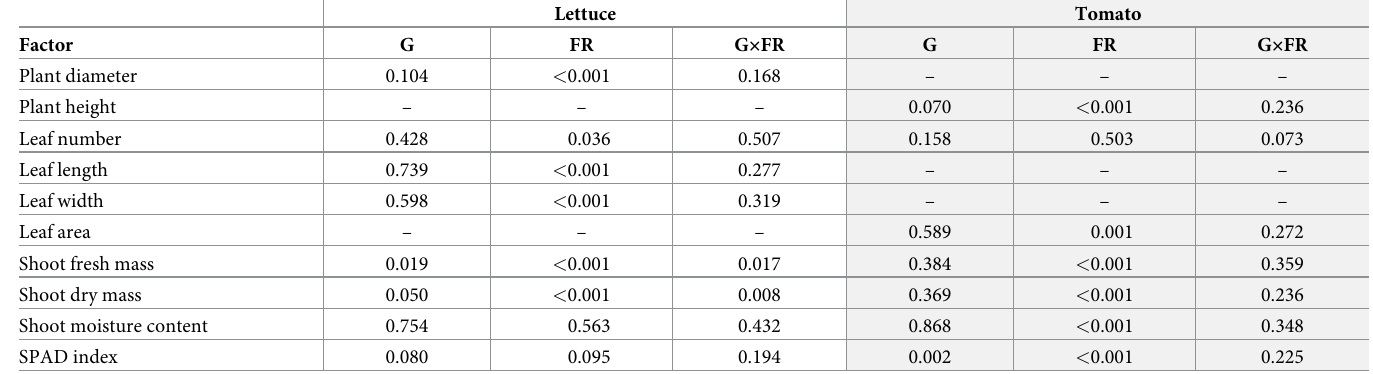
Table 2. Results from two-factor analysis of variance. P values are listed for the effects of green (G, 500–600 nm) light, far-red (FR, 700–800 nm) light, or their interac- tion on plant growth parameters of lettuce and